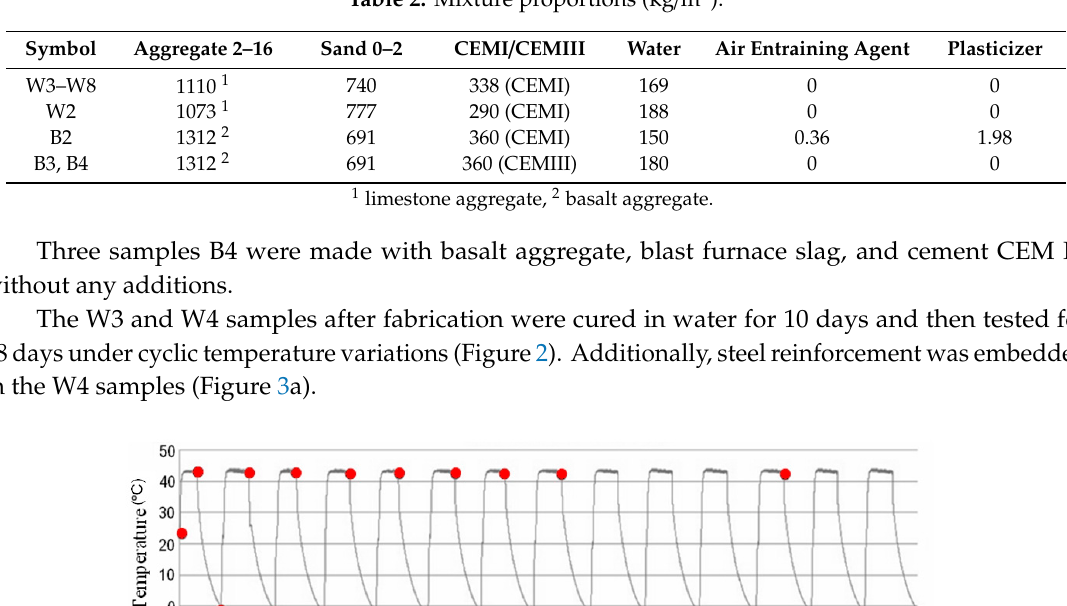
Table 2. Mixture proportions (kg/m 3 ).